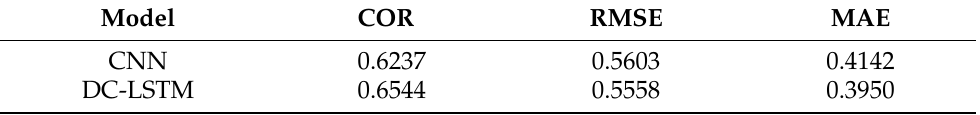
Figure 8. Comparison of the ENSO correlation skill between the DC-LSTM and dynamic models. Table 5. Quantitative prediction results of different methods at a lead time of 20